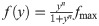
Quantifying fitness landscape and selection strength for the simulation data of clonal cell proliferation.A. Cell proliferation model with phenotype fluctuations. Individual cells divide according to the instantaneous fitness f(yt), which depends on the current phenotypic state yt (different colors indicate different phenotypic states). yt fluctuates in time, causing fitness fluctuations on single-cell lineages. B. Stationary probability of the phenotypic state without selection (filled curve, log-normal distribution with mean 1 and standard deviation 0.3) and instantaneous fitness depending on phenotypic states (Hill function, colored dashed lines with different Hill coefficients, n = 0, 2 and 10). C. Fitness landscapes. We produced the datasets of clonal cell proliferation by simulation, in which we assumed that cells stochastically change phenotypic state y and divide in a phenotype-dependent manner with the division rate f(y)=yn1+ynfmax. We calculated fitness landscapes h(y¯) from the simulation data for the conditions of n = 0, 2, and 10. In all the conditions, h(y¯) (points) recovered the assigned phenotype-dependent division rate f(y) (broken curves) with good precision. The points and the error bars represent means and standard deviations of results from 10 independent simulations (same in B and C). D. Dependence of mean fitness 〈h(y¯τ)〉cl and 〈h(y¯τ)〉rs on Hill coefficient. Strengthening the phenotype dependence of fitness by increasing the Hill coefficient of f(y) caused 〈h(y¯τ)〉rs (magenta circles) to be greater than 〈h(y¯τ)〉cl (green squares). In our definition, selection strength for phenotype y¯τ is given by 〈h(y¯τ)〉rs-〈h(y¯τ)〉cl (Eq 7), thus the deviation directly indicates the existence of selection acting on phenotype y¯τ. E. Dependence of relative selection strength Srel[y¯τ]=S[y¯τ]/S[D] on Hill coefficient.